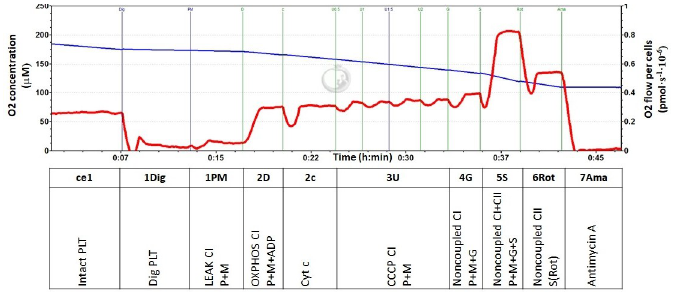
Fig 1. Respirometric analysis of mitochondrial function in human platelets. The trace from the measurement of platelet (PLT) respiration at 37˚C in a respiration medium MiR05 and 20 mM creatine. The blue line